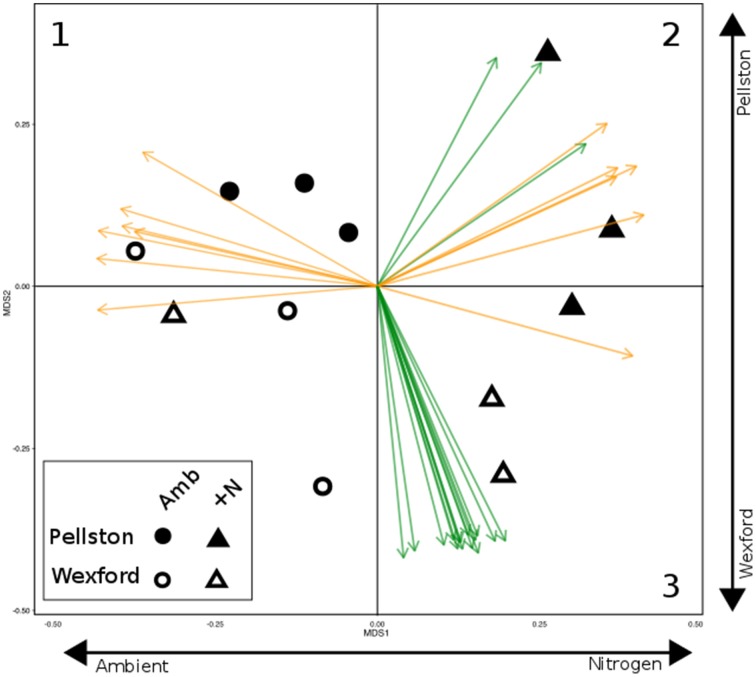
Non-metric multidimensional scaling ordination of field sample metatranscriptomes based on CAZyme transcript composition. Samples ordinated first by N treatment (horizontal axis) and second by site (vertical axis). Vectors denote highly significant correlation with ordination axes (p < 0.001). Orange vectors represent eukaryotic CAZymes and green vectors represent bacterial CAZymes. Numbers in the three quadrants illustrate CAZymes that are noted in the Figure 2 heat map. [1, eukaryote CAZymes enriched in ambient plots in both forests; 2, eukaryotic and bacterial CAZymes enriched in Pellston N-amended plots; 3, bacterial CAZymes enriched in Wexford N-amended plots]. Clustering of ambient and N-amended plots was significantly different from one another (PERMANOVA, N amendment p = 0.02) with a significant interaction between site and treatment (p = 0.039). Post-hoc tests revealed the effect of treatment was highly significant at Pellston (p = 0.001) and not significant at Wexford (p > 0.1). See Supplementary Table S1 for names and functions of individual vectors.